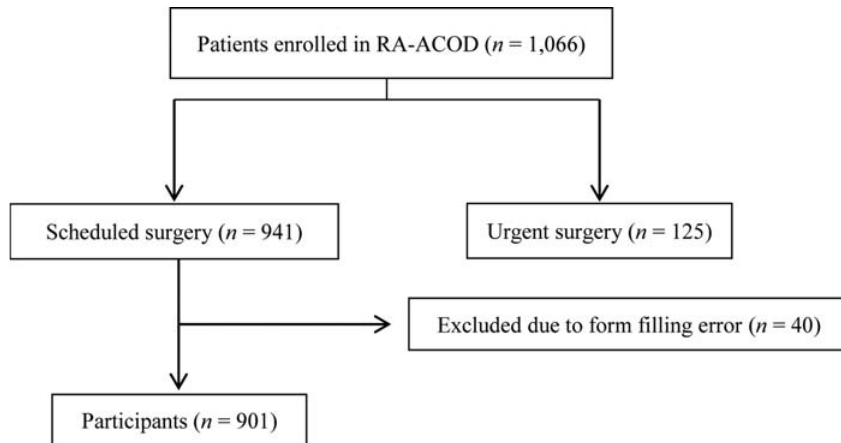
Fig. 1 Recruitment fl owchart. Table 1 Patients and procedures characteristics Total subjects ( n